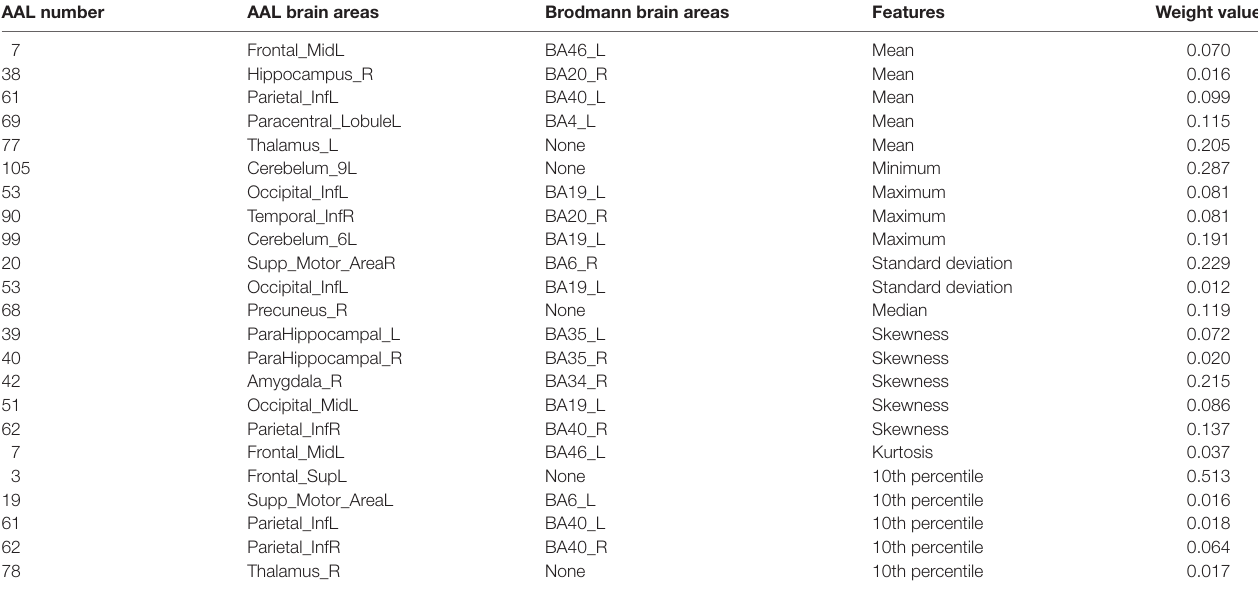
TABLE 2 | Different brain regions between Parkinson’s disease patients and healthy controls.